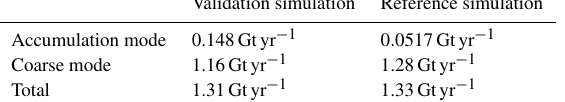
Table 2. Parameters of emission and GMXe dust modes. The GMXe parameter values shown have been used for reference and validation simulations.